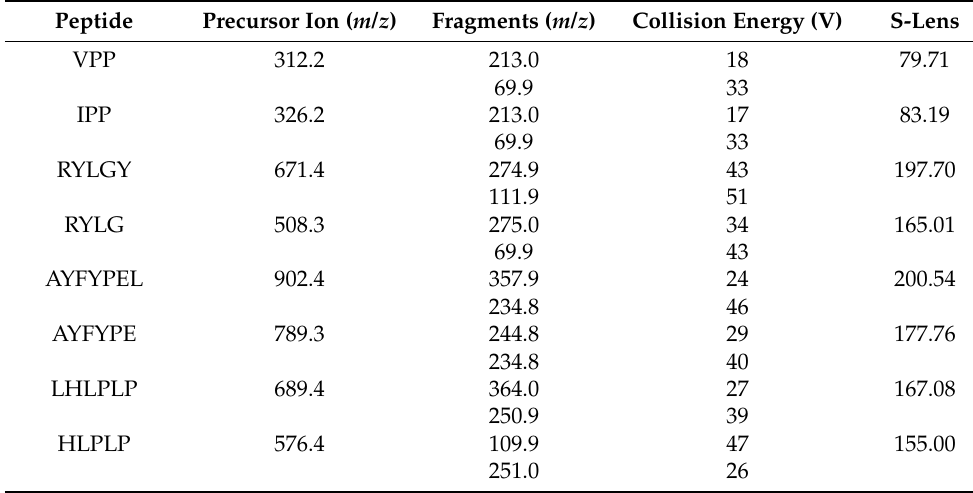
Table 2. MS/MS parameters used for the SRM (Selected Reactions Monitoring)